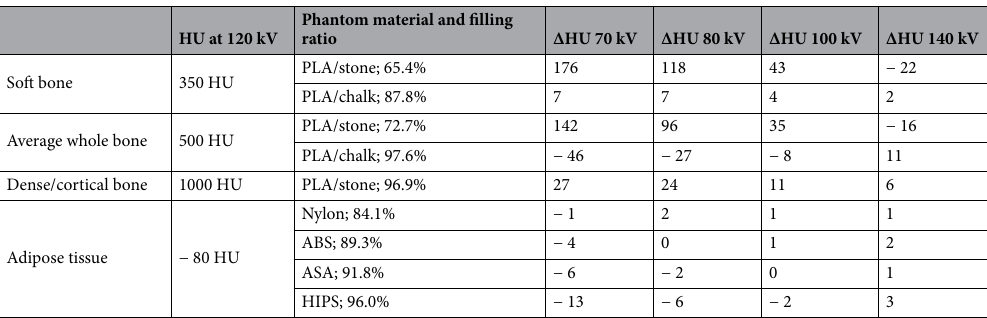
Table 3. Calculated differences in CT values between the tissue mimicked, and the polymers with equal X-ray attenuation at 120 kV. Dense bone is best duplicated by PLA/chalk, while dense/cortical bone can be appropriately mimicked by PLA/stone. Nylon best imitates adipose tissue, while ABS and ASA are also within a few HU at all